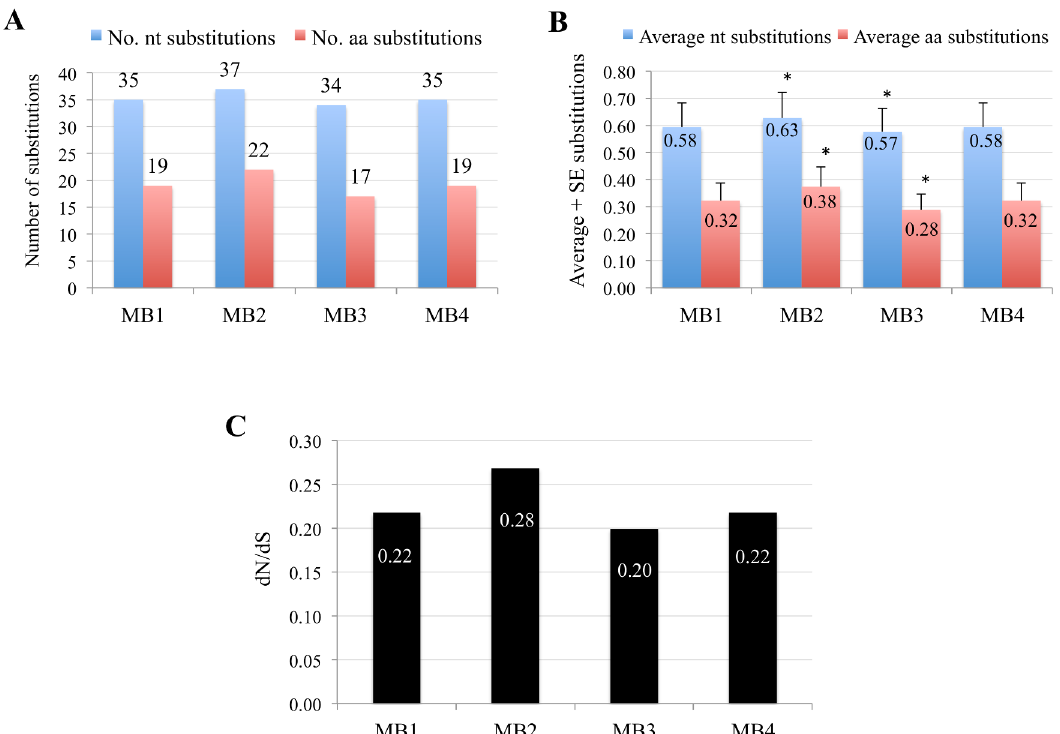
Fig 7. Nucleotide substitution rate analysis in antigen-coding genes. (A) The total number and (B) the average + standard error (SE) of nucleotide (nt) and amino acid (aa) substitutions were calculated in 81 antigen-coding genes conserved in MB1-MB4 isolates using M . tuberculosis H37Rv as a reference. Average values were compared between isolated using a χ 2 test ( * P < 0.0001). (C) The dN/dS ratio was determined on the basis of the number of non- redundant synonymous and non-synonymous changes using the SLAC algorithm and a two-tailed extended binomial distribution was used to assess significance of the algorithm (P < 0.05).